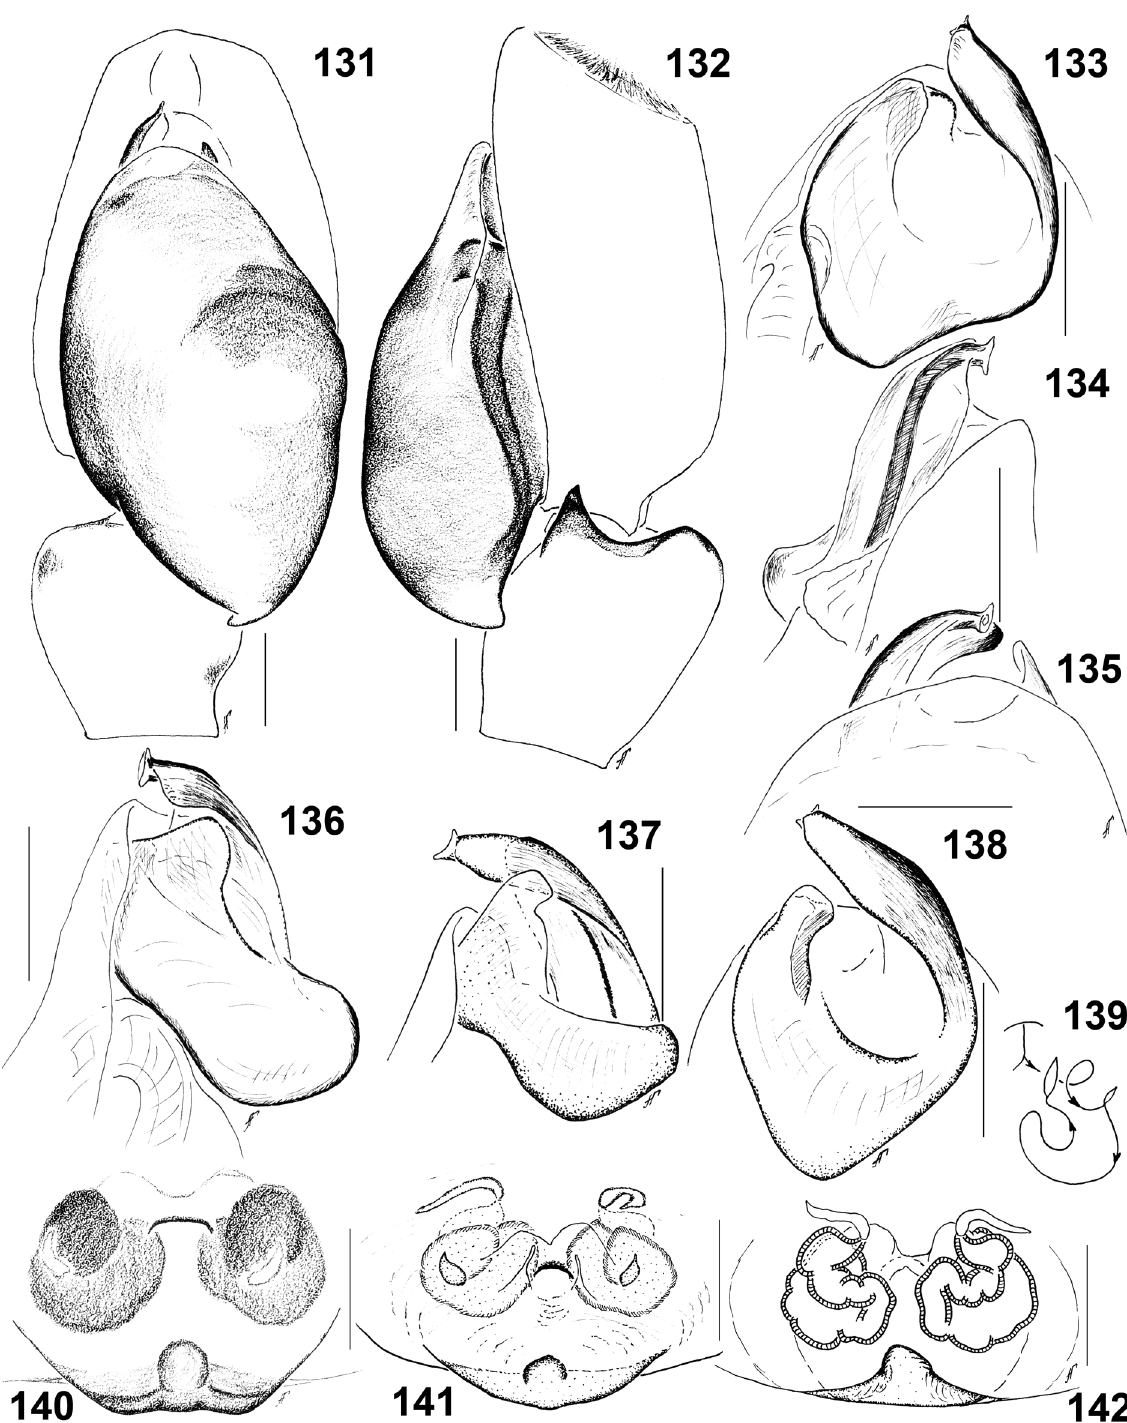
Figs 131–142. Manzuma nigritibia (Caporiacco, 1941) gen. et comb. nov., holotype of Saitis nigritibiis , ♂ (137–138), ♂♂ from Ethiopia (Awash NP, MRAC) (131–136), holotype of Aelurillus reconditus , ♀ (139–142). 131–132 . Male palp. 131 . Ventral view. 132 . Retrolateral view. 133–138 . Embolic division. 133, 138 . Dorsal view. 134 . Prolateral view. 135 . Ventral view. 136–137 . Retrolateral view. 139 . Diagrammatic course of the insemination ducts. 140–142 . Epigyne. 140 . Ventral view. 141 . Ventro- apical view. 142 . Spermathecae, dorsal view. Scale bars: 0.1